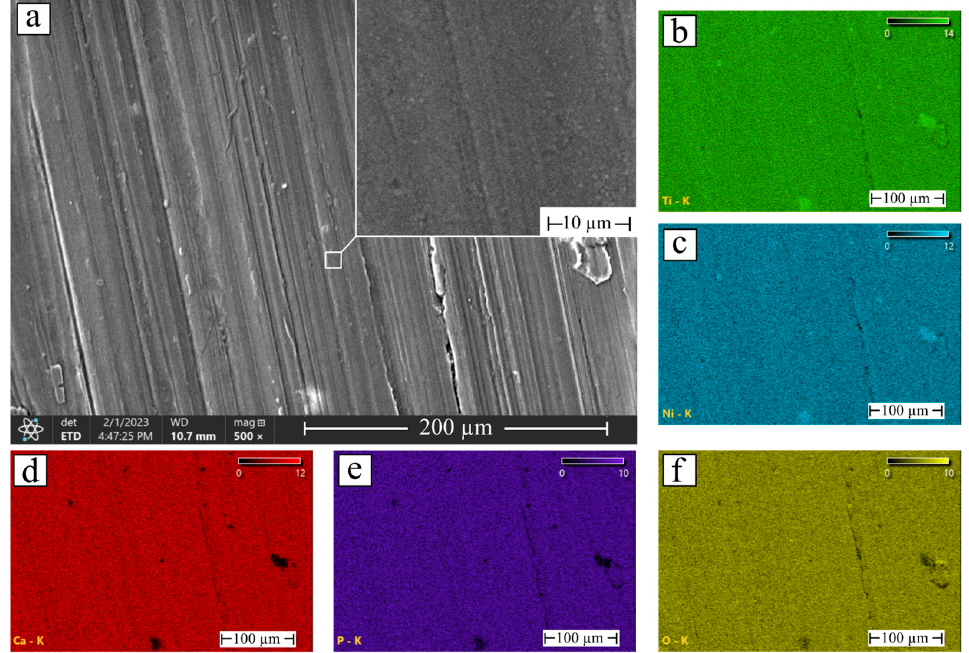
Figure 2. ( a ) SEM image of the NiTi with hydroxyapatite coating deposited for 1 h and elemental maps of: ( b ) Ti; ( c ) Ni; ( d ) Ca; ( e ) P; and ( f ) O.